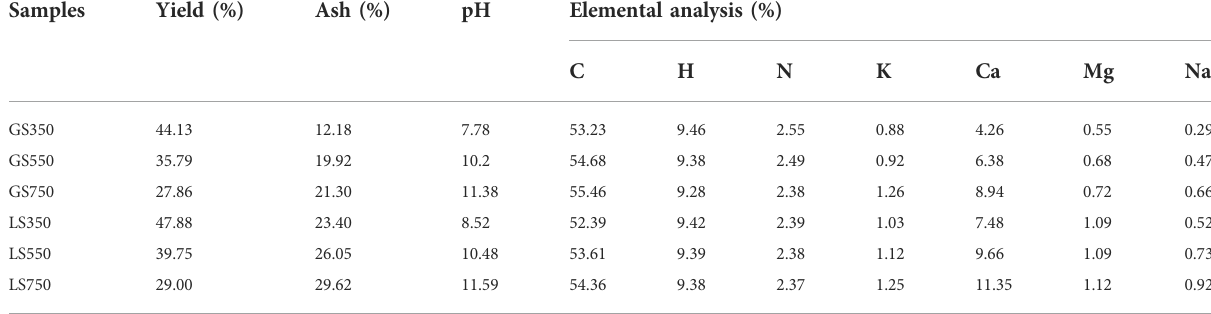
TABLE 1 The physicochemical properties of GSBC and LSBC.